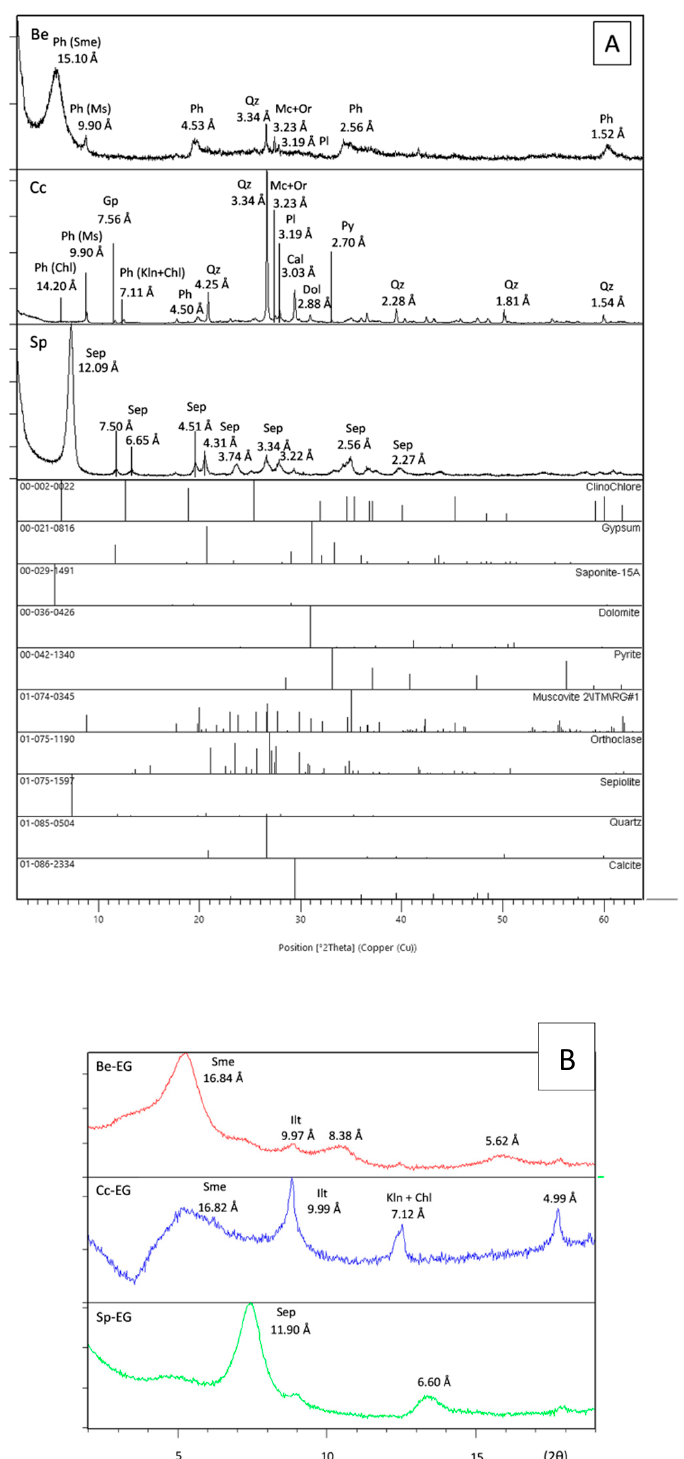
Figure 2. The XRD diffraction patterns of the M1 (Be), M2 (Sp) and M3 (Cc) samples: ( A ) the bulk sample and ( B ) the clay fraction (ethylene glycol solvated oriented mounts). With the exception of phyllosilicates (Ph), the IMA (International Mineralogical Association) abbreviations were used. Gp = Gypsum. Qz = quartz. Mc + Or = K-feldspar. Pl = Plagioclase. Cal = Calcite. Dol = Dolomite. Kln + Chl = Kaolinite+chlorite. Sme = Smectite. Sep = Sepiolite. Ilt = Illite. Ms = Muscovite. Py =